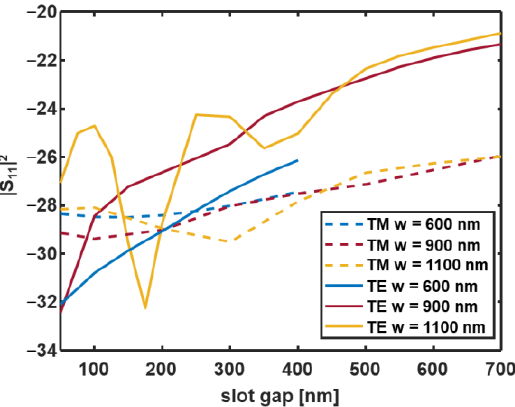
Figure 6. Power reflection coefficient |S 11 | 2 calculated at the input port for the TE (solid curve) and TM modes (dashed curves) as a function of the initial slot gap value g. The blue, red, and yellow curves correspond to configurations A (w = 600 nm), B (w = 900 nm), and C (w = 1100 nm), respec- tively. For each value of the slot gap g, the slot rail width s can be calculated from the formula s = (w − g) / 2. The wavel ength is λ = 1.55 µm.